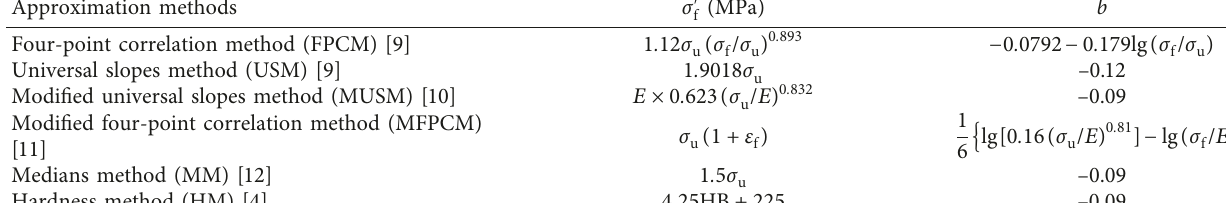
Table 4: Approximation methods for Basquin’s fatigue properties.